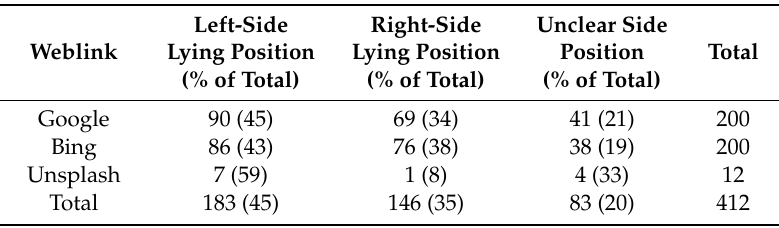
Table 3. Number and calculated percentage of sheep lying on their left and right side, or of uncertain laterality, from three online photographic image search engines in Experiment 2.